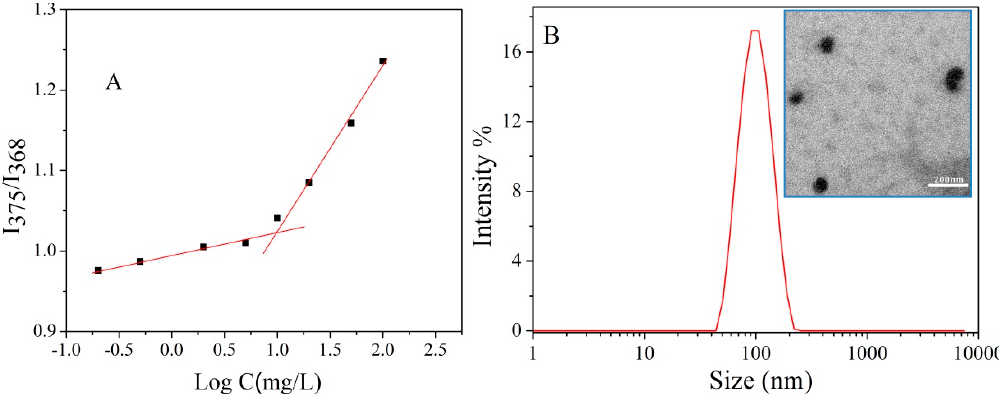
Figure 2. Intensity ratios of I 375 /I 368 of pyrene as a function of copolymer concentrations ( A );